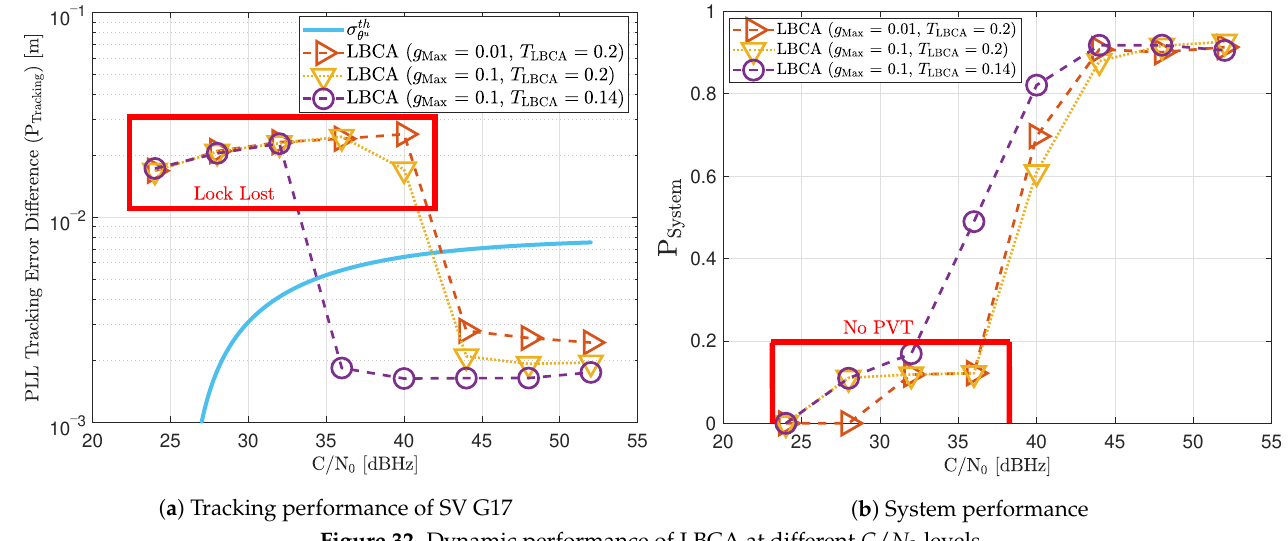
Figure 32. Dynamic performance of LBCA at different C / N 0